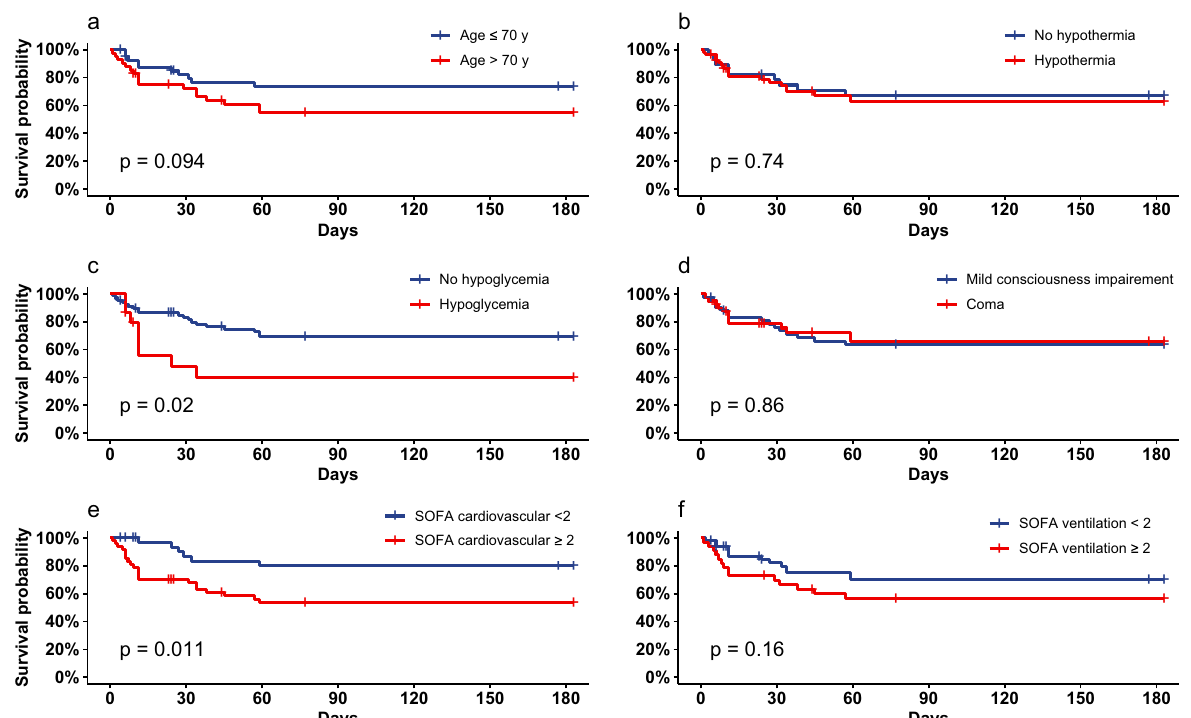
Fig. 2 Six‑month survival according to A age, B hypothermia, C hypoglycemia, D coma, E cardiovascular component of the SOFA score, and F ventilation component of the SOFA score